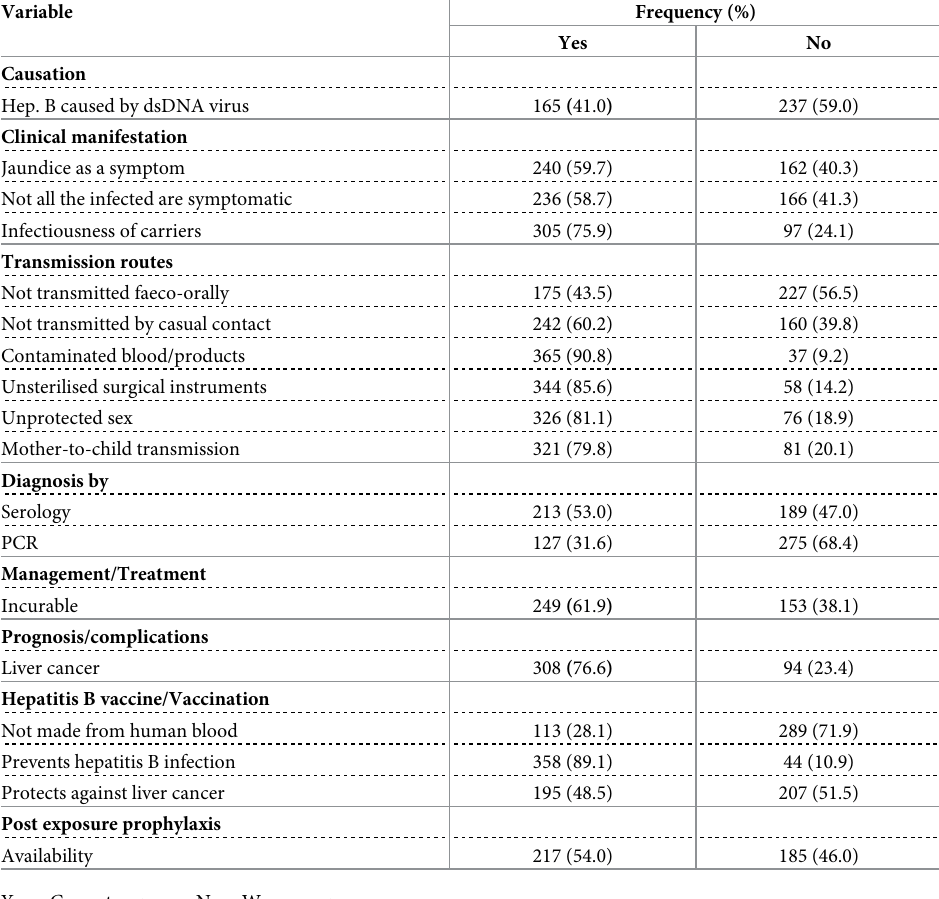
Table 2. Knowledge of hepatitis B infection prevention (n =